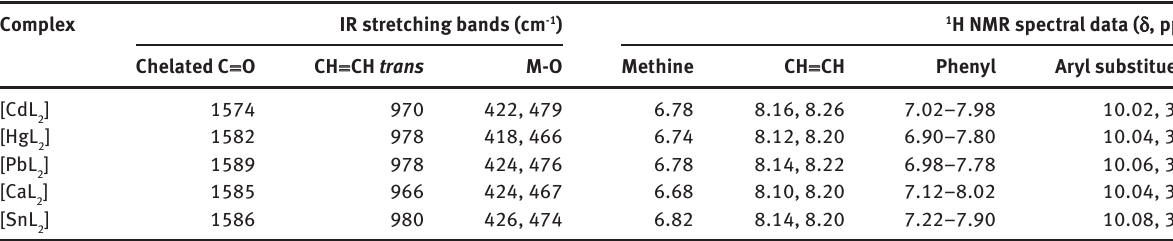
Table 2 IR and 1 H NMR spectral data of the metal complexes of curcumin. Complex